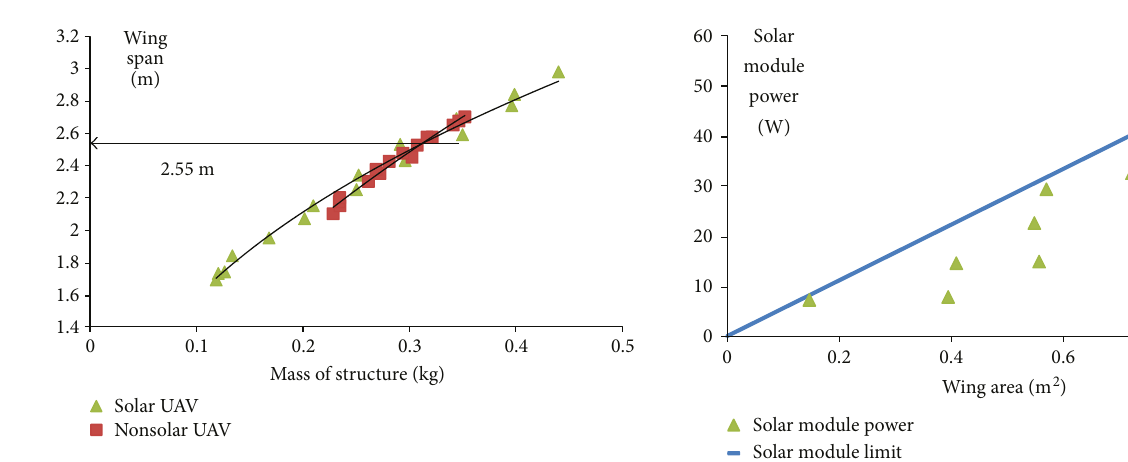
Figure 4: Mass of the structure versus wing span of the solar and nonsolar UAVs at 0.35kg payload.